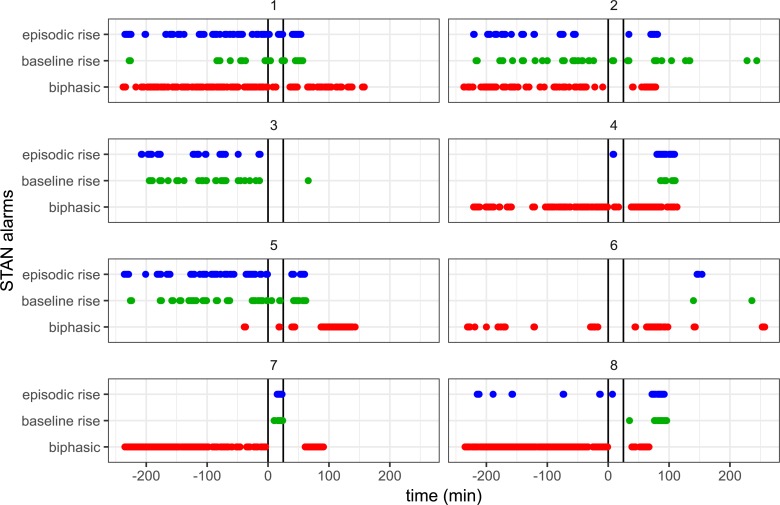
STAN-events during normoxemia and hypoxemia.Subjects with STAN-events in 1-minute windows during the 4 h baseline period and during the 25 minute transient umbilical cord occlusion (indicated by vertical black lines). The events assessed are episodic T/QRS rise (blue), baseline T/QRS rise (green) and biphasic ST events (red). The numbers refer to individual subject numbers.